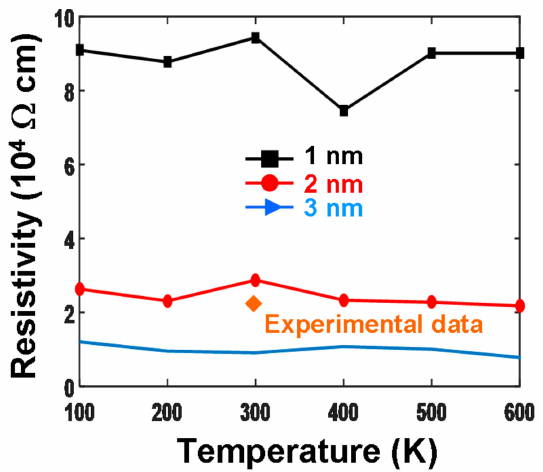
Figure 10. The plot of resistivity vs temperature ranging from 100 to 600 K of ITO structures at different